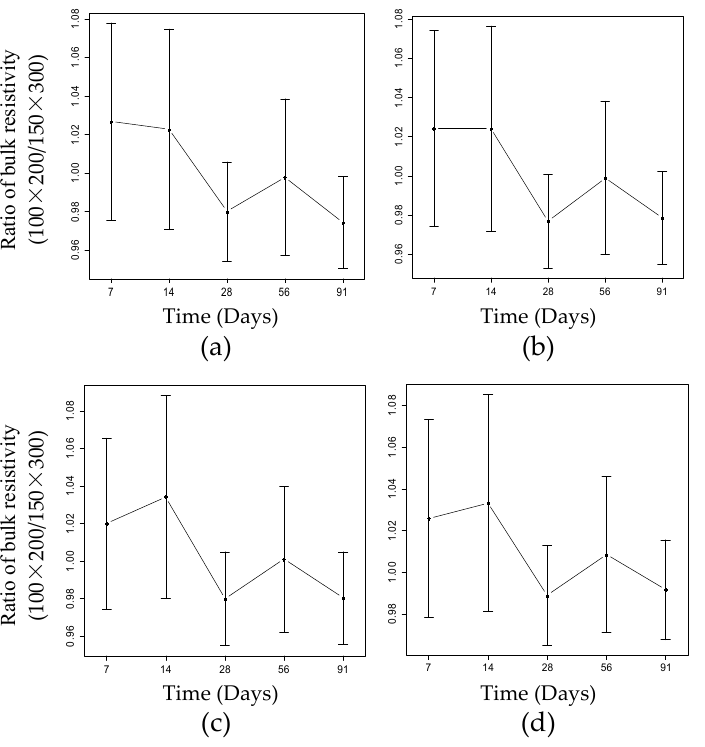
the mean of the ratios. The portion of the line from that point to the bottom and top represents the